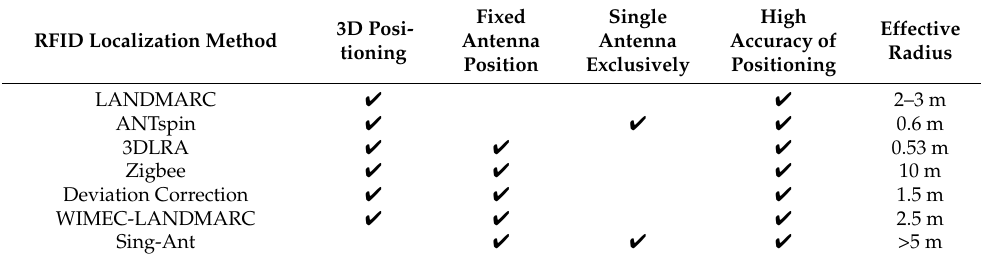
Table 5. Model comparison.